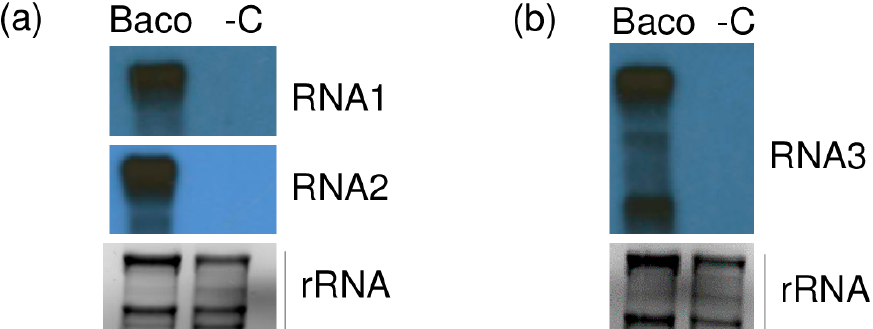
Figure 4. Validation of the presence of GLPV in a diseased vine by Northern blot. X-ray films exposed after hybridizations using ( a ) RNA1 and RNA2, ( b ) RNA3 radioactively labelled virus-specific riboprobes. “Baco” marks the RNA from the GLPV-infected vine, while “-C” the RNA from a non-infected vine. EtBr-stained agarose gels before blotting served as a loading control.